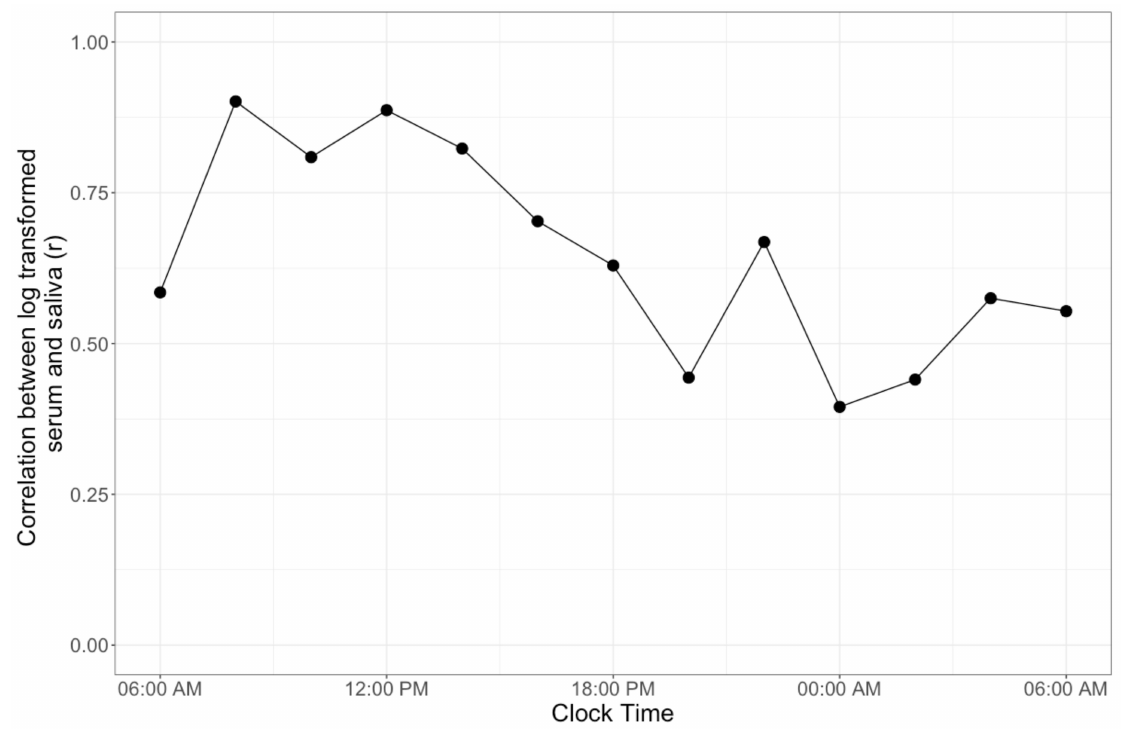
Figure 2. The correlation of log transformed saliva and serum cortisol across the 24-h profile. The correlation was greatest at 0800 (r = 0.90) but demonstrated a general decrease across the remainder of the profile.